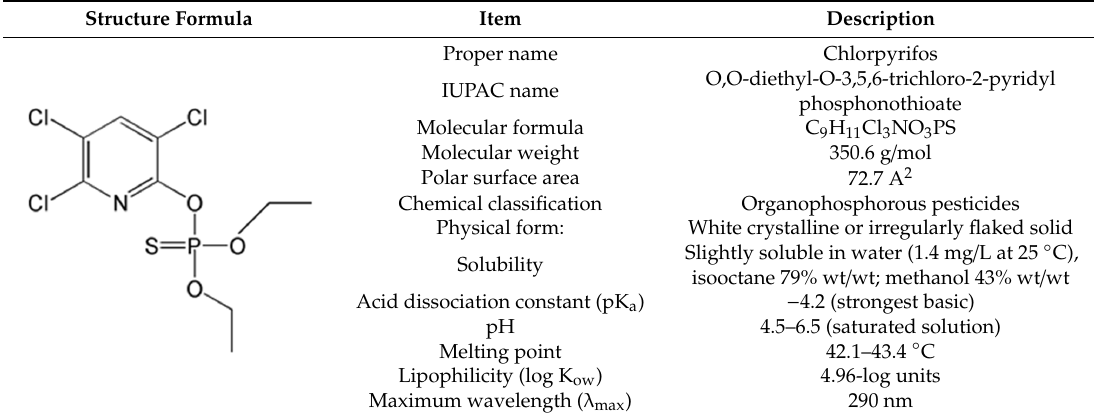
Table 1. Structure and Physicochemical Classification of Chlorpyrifos.